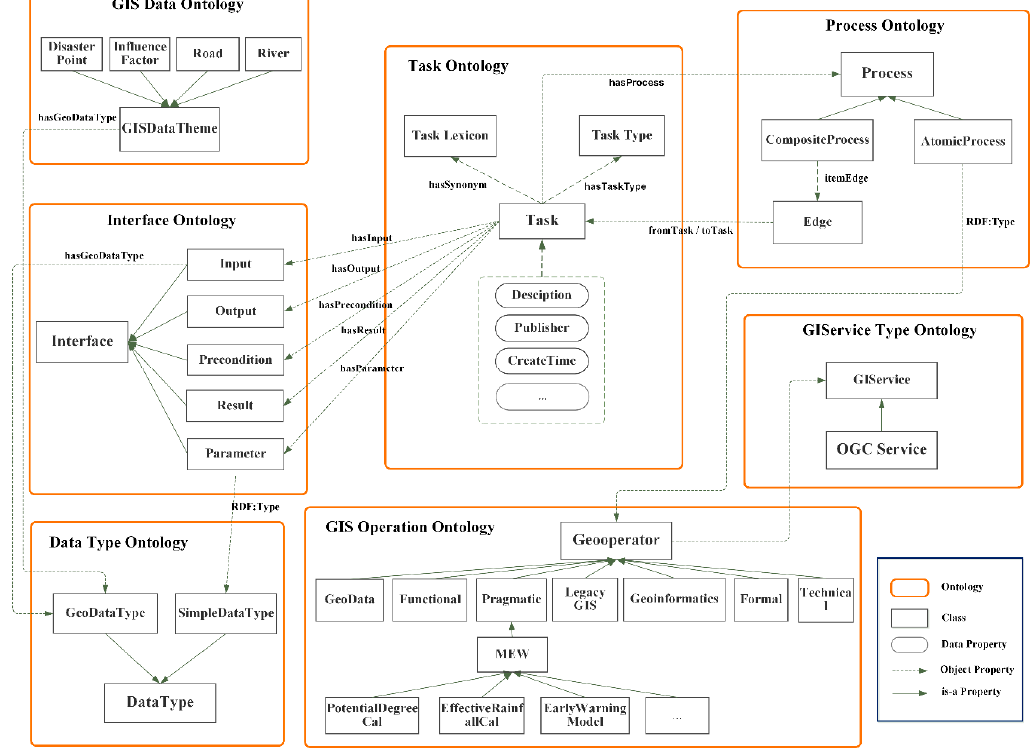
Figure 5. The relationships of ontologies in the knowledge base.